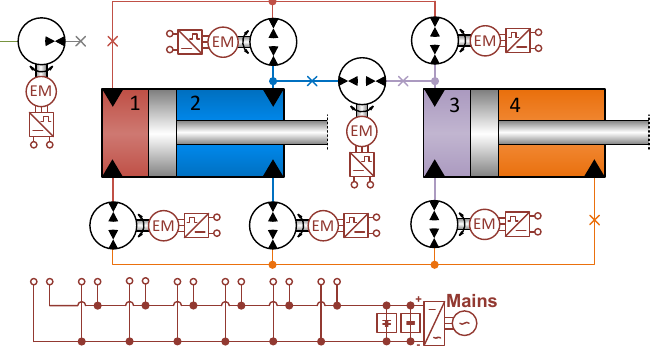
Figure 1. Electro-hydraulic variable-speed drive network in dual cylinder system with VsD intercon- nections between all four chambers. Here, × marks possible points at which VsD(s) can be connected to link the system to a